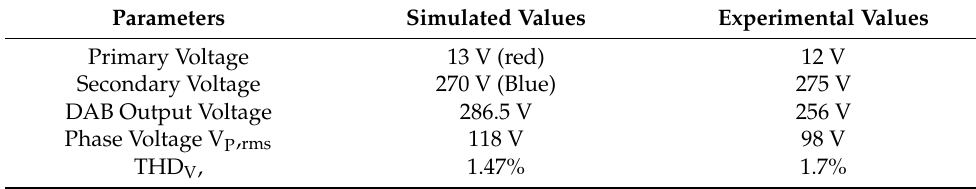
Table 6. Simulated and experimental results